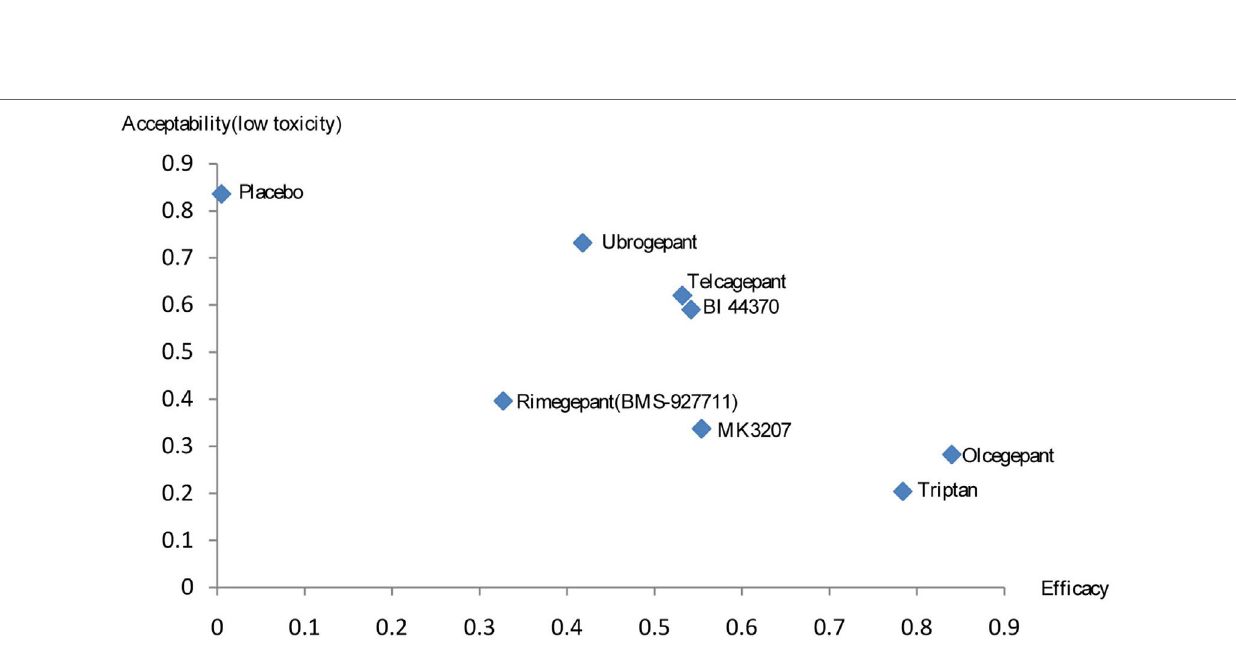
FIGURE 6 | Rank results for efficacy and acceptability (low